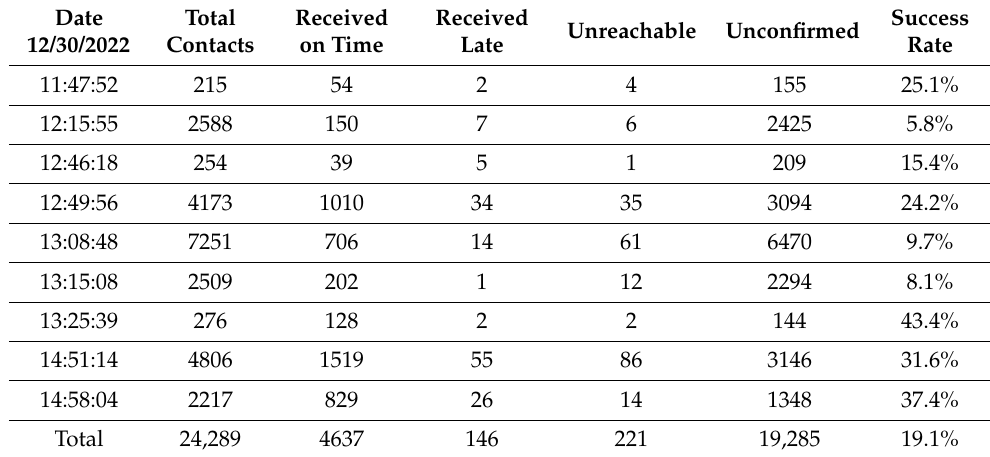
Table 1. Notifications from Boulder County’s Emergency Notification